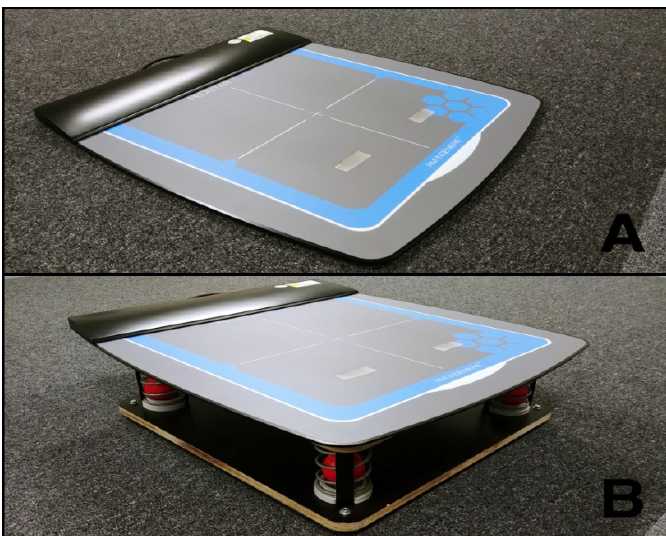
Figure 2. BioRescue plate for static standing balance ( A ); BioRescue plate for dynamic standing balance ( B ).